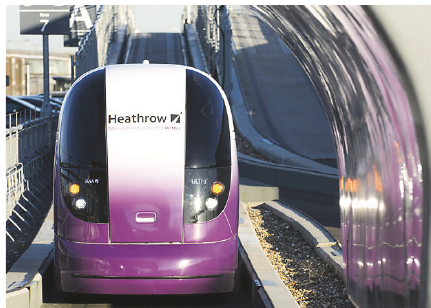
Figure 1: PRT vehicle (source: www.ultraglobalprt.com).